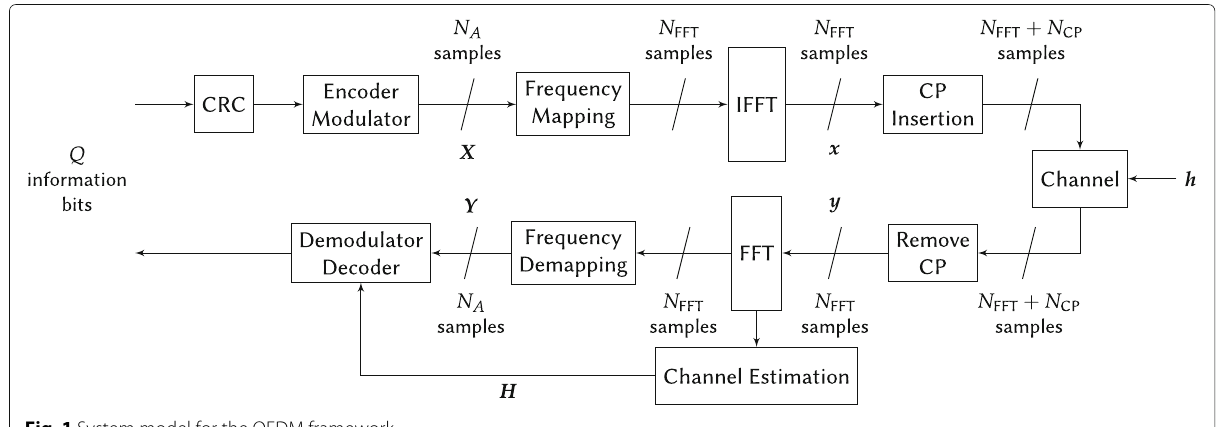
N FFT × N s . Inverse discrete Fourier transform (IDFT) of size N FFT is then applied to convert the frequency sig- nal into a time signal consisting of N FFT × N s samples (or chips). The inverse fast Fourier transform (IFFT) algo- rithm is used in practice to perform the IDFT. Considering the vector X of length N FFT , the discrete-time sequence of the considered OFDM symbol x is given